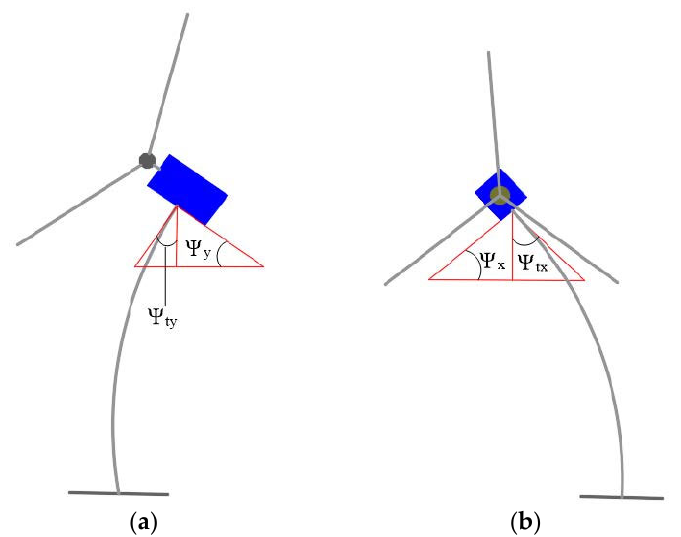
Figure 7. Relationship between tower turning angle and cabin attitude. ( a ) Forward and backward. ( b ) Left and right.